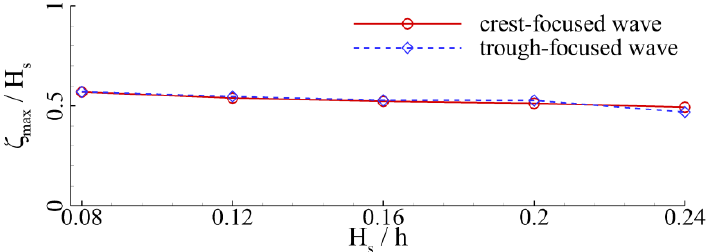
Figure 18. Maximum water surface elevation at the reef crest versus the relative significant wave